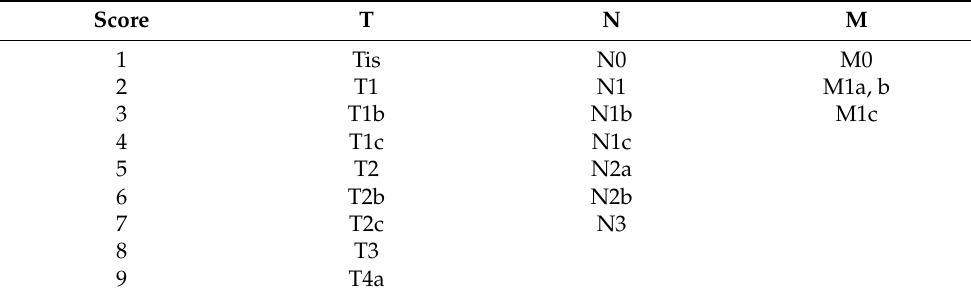
Table 1. Conversion of TNM stages to numerical scores for statistical analysis. Score T N